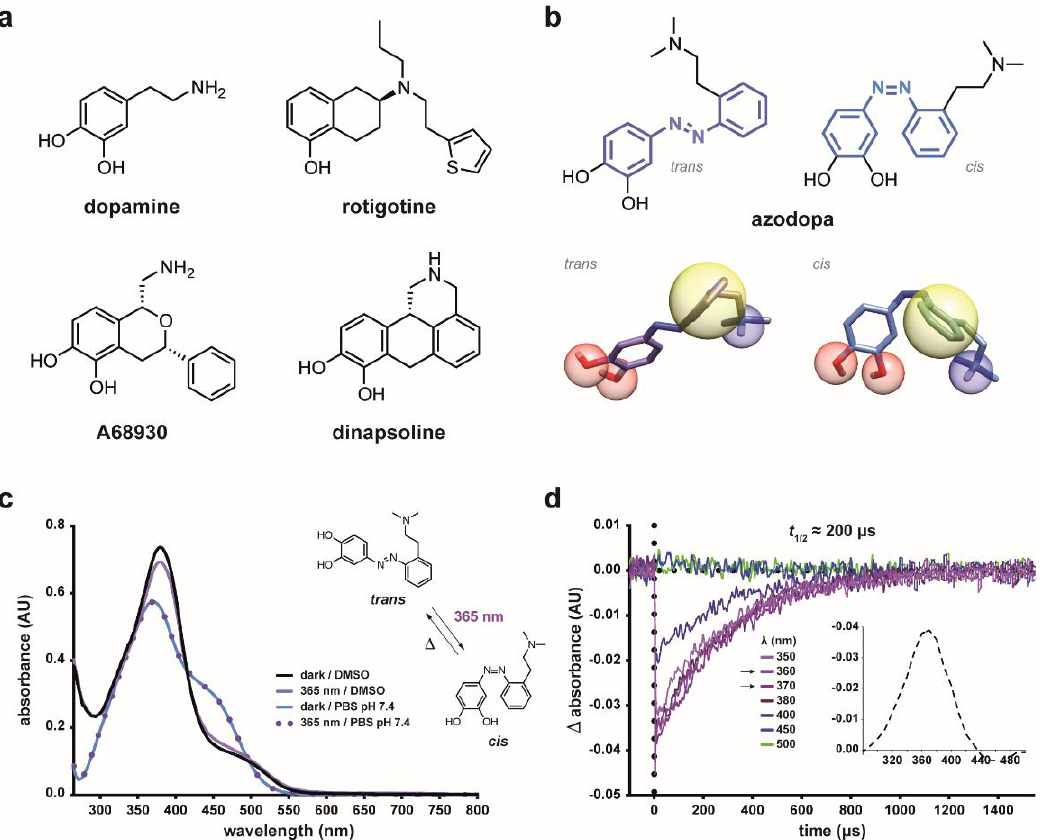
Figure 1. Design, structure, and photochromism of azodopa. ( a ) Chemical structure of dopamine and representative (semi)rigidified derivatives: rotigotine (nonselective agonist), A68930 (D 1 agonist), and dinapsoline (D 1 agonist). ( b ) 2D and 3D chemical structure of the photochromic dopamine